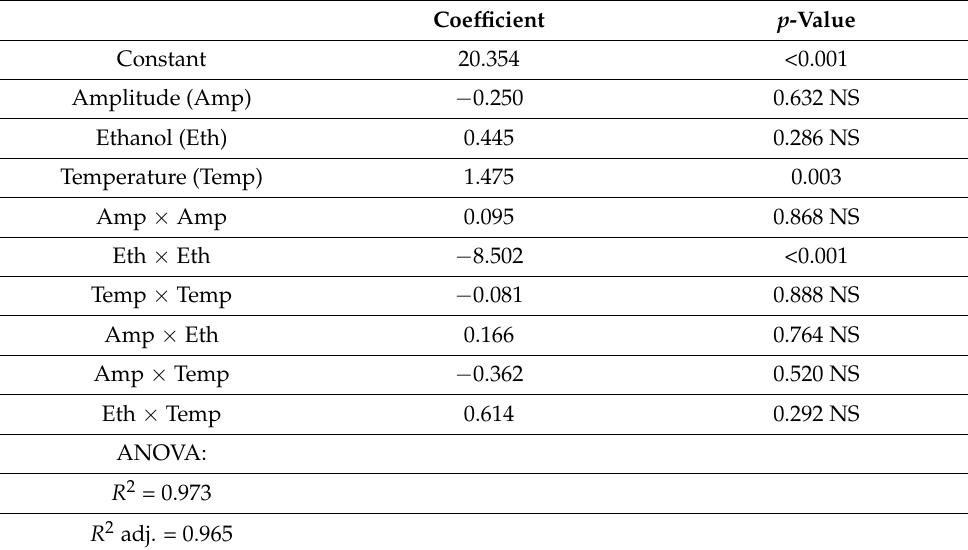
Table 3. Model equation coefficients and statistical